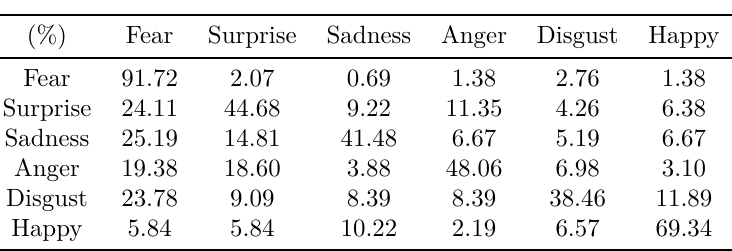
Table 1. The confusion matrix of the HMM that has 4 states and 40 Gaussian components; the accuracy of the emotion recognition from speech model is 55.90% for six basic emotion categories.